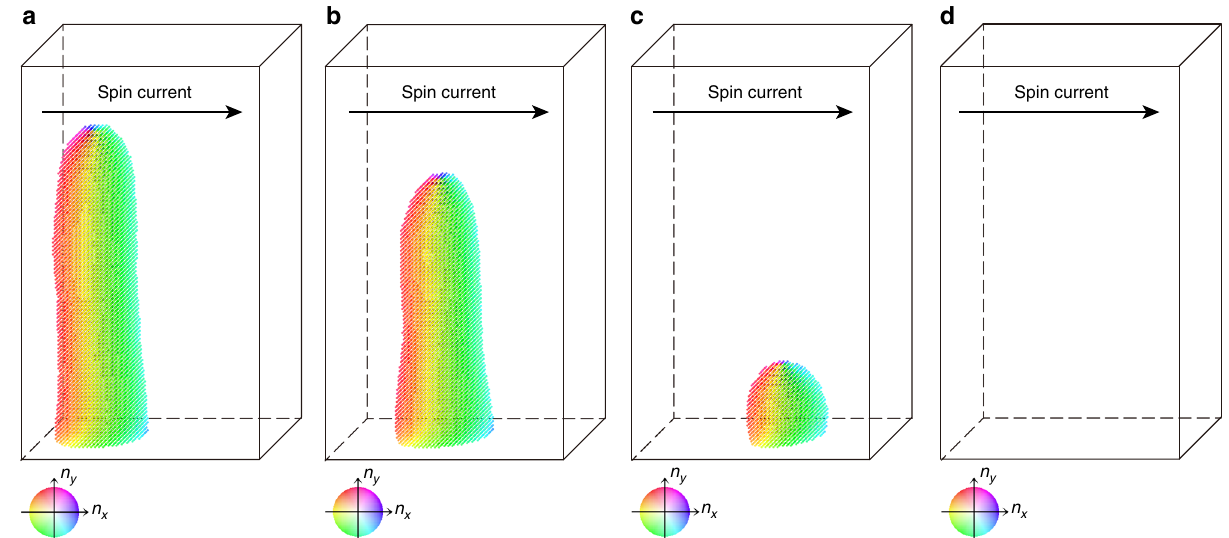
Fig. 4 Micromagnetic simulations for a segmented skyrmion string. a Initial magnetic state of the simulations, which is metastable under zero current. b – d Snapshots of the current-induced dynamics of a segmented skyrmion string under j = 0.04: t = 250 ( b ), t = 500 ( c ), and t = 650 ( d ) in units of 1/( γ J ) (see the Methods section). The movie is available in Supplementary Movie 1. Color wheels specify the x – y plane magnetization direction. The brightness of the color represents the z component of the magnetization; that is, the local magnetizations pointing toward the z direction are displayed as white. For the details of the calculation, see the Methods section